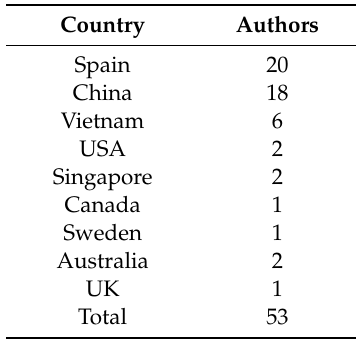
Table 1. Statistics of authors by country. Country Authors